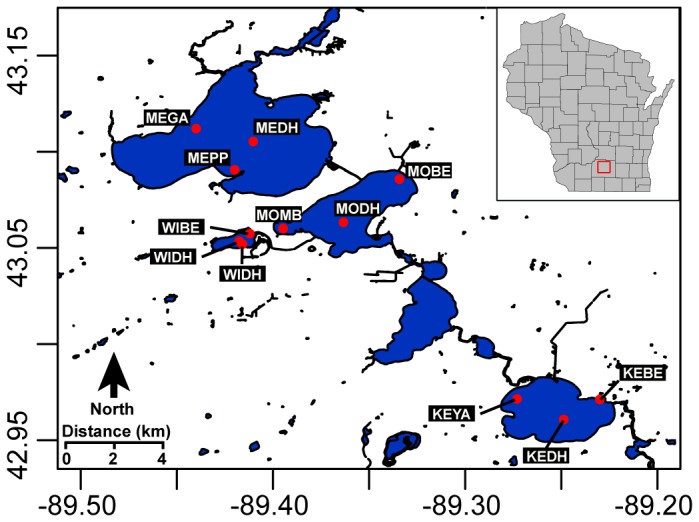
Sampling locations in lakes of the Yahara Watershed.Three locations in each of four lakes were sampled on a weekly basis late May through October.